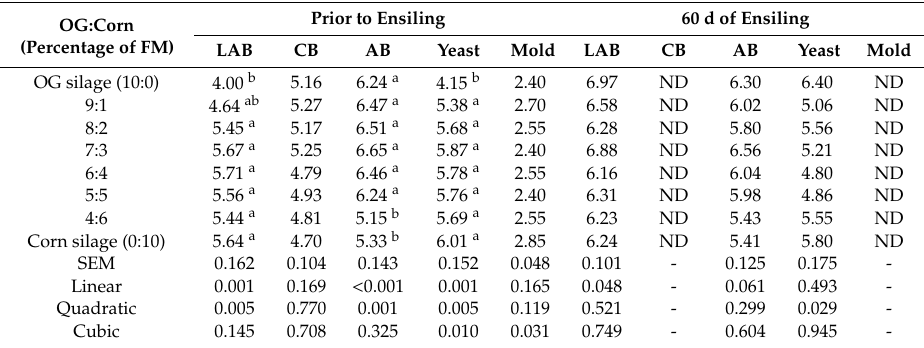
Table 1. Microbial populations (log 10 cfu / g FM) of Oxytropis glabra (OG) mixed with whole-plant corn at di ff erent ratios prior to and after 60 d of ensiling.